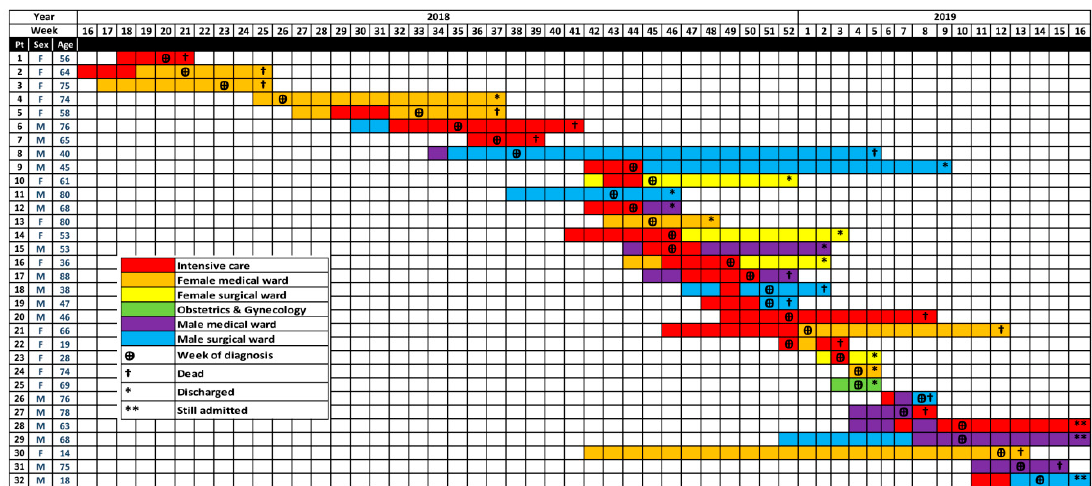
Figure 1. Patient location and transfer within the hospital in relation to diagnosis and outcome time (weeks of year) during the outbreak.